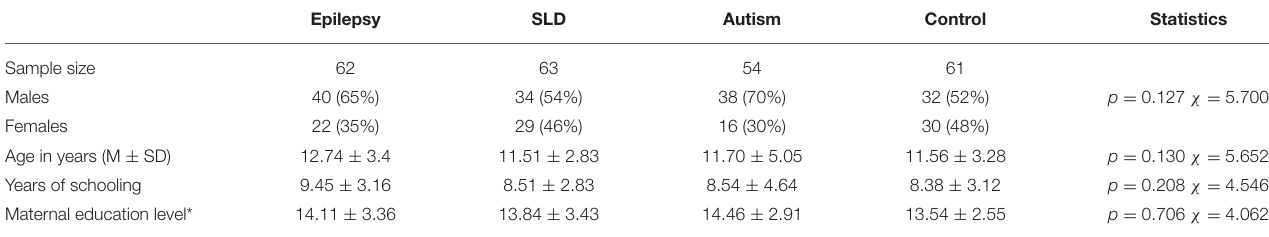
TABLE 1 | Sample characteristics.